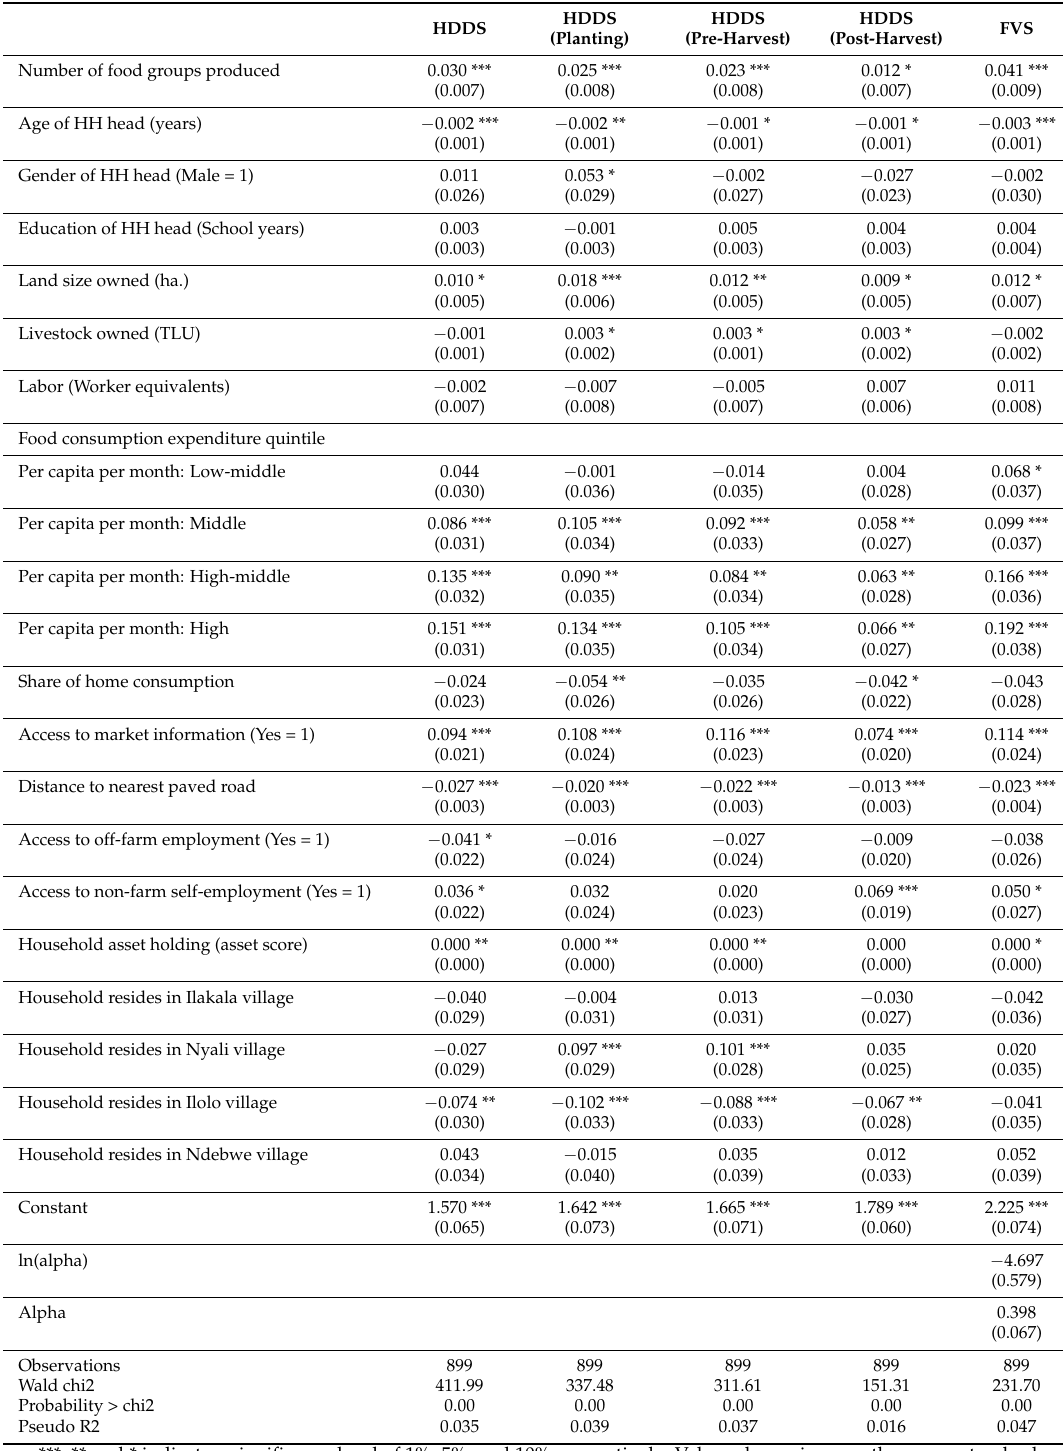
Table 6. Effects of farm production diversity on household food consumption diversity – Pooled sample (Farm production diversity indicator: Number of food groups